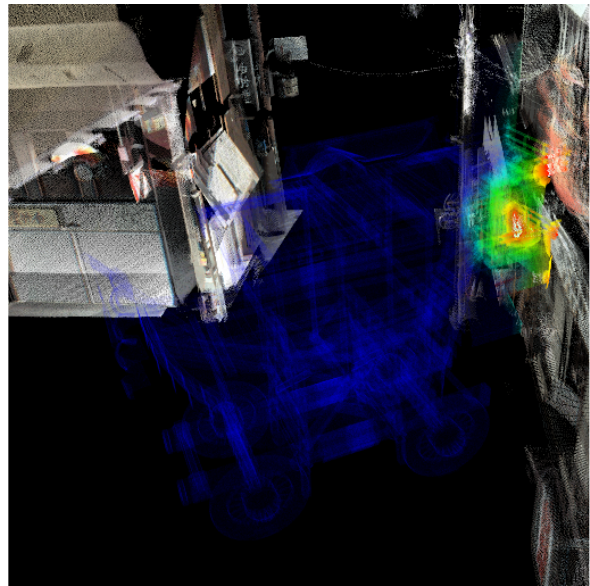
Figure 14. See-through collision visualization during the turning of the float at a street intersection. The total number of points used for the visualization is 1 . 1 × 10 ! , and the rendering speed is 13.21 fps.